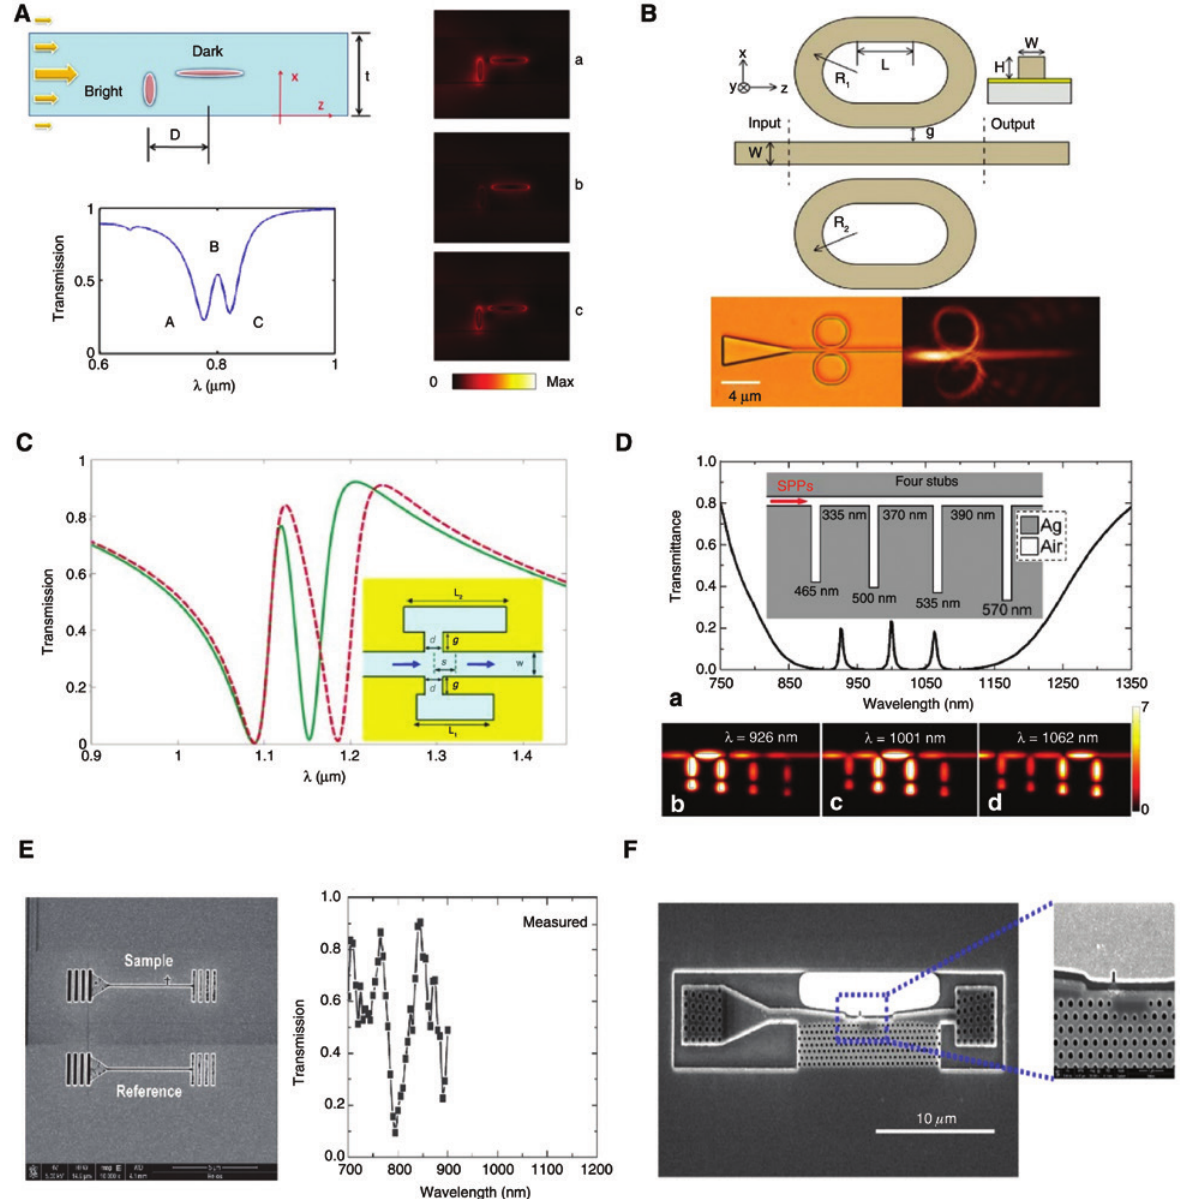
Figure 3: In-plane coupling PIT structures with incident light injected through